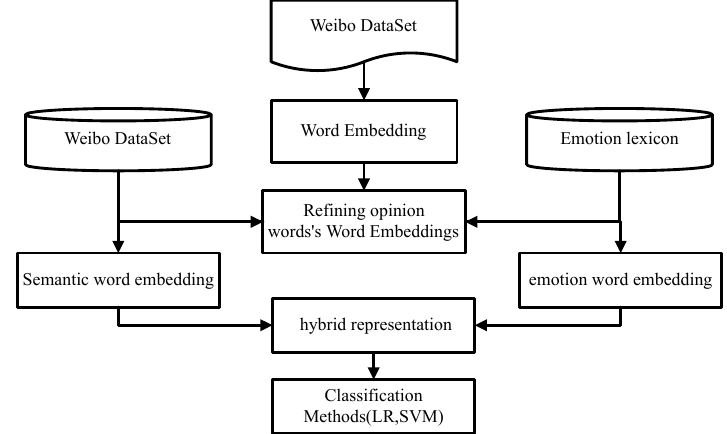
Figure 1. Framework for the proposed